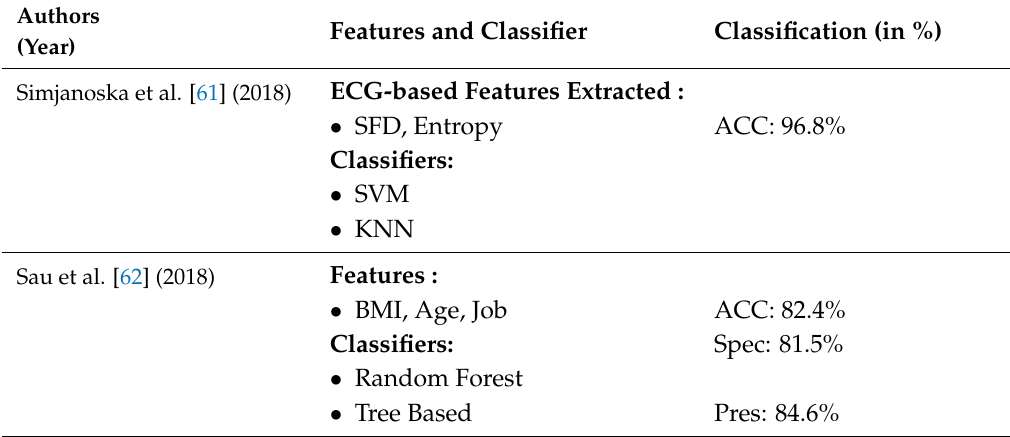
Table 8. Comparison of work done for automated detection of hypertension ECG signals. HRV, heart rate